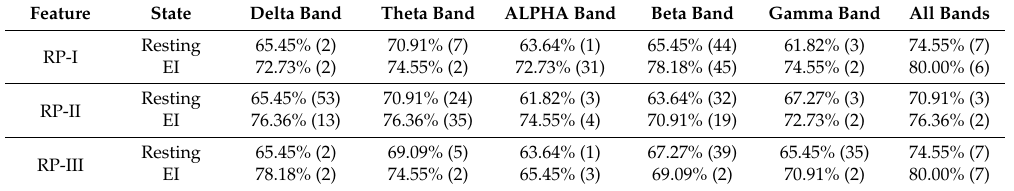
Table 1. A comparison of linear discriminant analysis (LDA)-based leave-one-participant-out cross-validation (LOPO-CV) classification accuracy between the resting and the emotion-induction (EI) states in different conditions of frequency bands. The number in the parenthesis refers to the best number of N